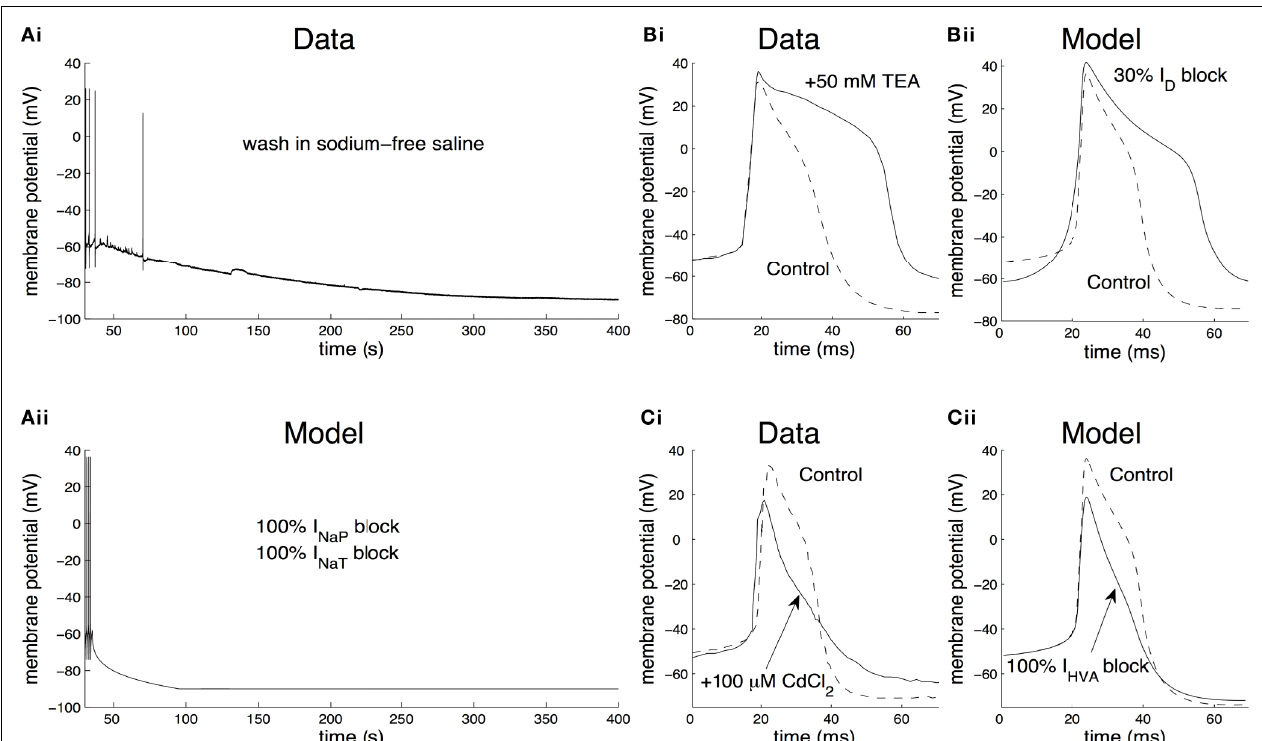
FIGURE 5 | Contribution of identifi ed ionic currents to the electrical properties of the CGCs. (A) Contribution of the total sodium current. When washing the preparation into sodium-free saline, CGCs from the intact nervous system cease to fi re and the membrane potential is signifi cantly hyperpolarized (Ai; also see Staras et al., 2002). In the model, washing into sodium-free saline was simulated by gradually setting the maximal persistent and transient sodium conductances ( g and g , respectively) to zero over a time interval of 60 s NaP NaT (Aii) . This is equivalent to completely removing the transient and persistent sodium currents from the model, inducing the cell to stop fi ring and the membrane potential to settle at a very negative value ( ∼− 90 mV), similarly to the biological neuron. (B) Contribution of the delayed rectifi er potassium current to spike shape. When blocking I by washing the preparation in 50 mM TEA D (tetraethylammonium chloride), the duration of the action potentials recorded from CGCs in the intact nervous system increased signifi cantly ( Bi ; also see